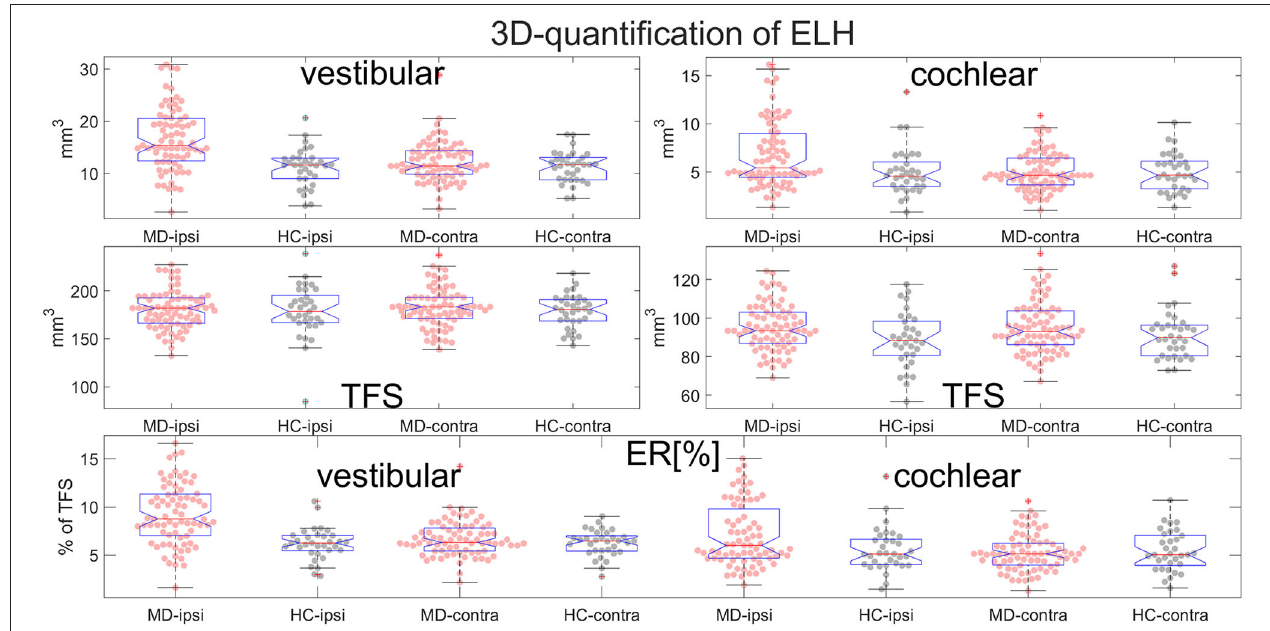
FIGURE 6 | Normalization and group differences for 3D-quantification of endolymphatic hydrops (ELH). 3D-quantification values of endolymphatic hydrops (ELH) in the vestibular and cochlear part of the inner ear [in mm 3 ] (top). 3D-quantification values of the total fluid space (TFS) of the vestibular and cochlear part of the inner ear [in mm 3 ] (middle row) that were used for normalizing the data of each individual to ELS ratio (ER) [%], the percentage of the TFS occupied by the ELH (bottom row).